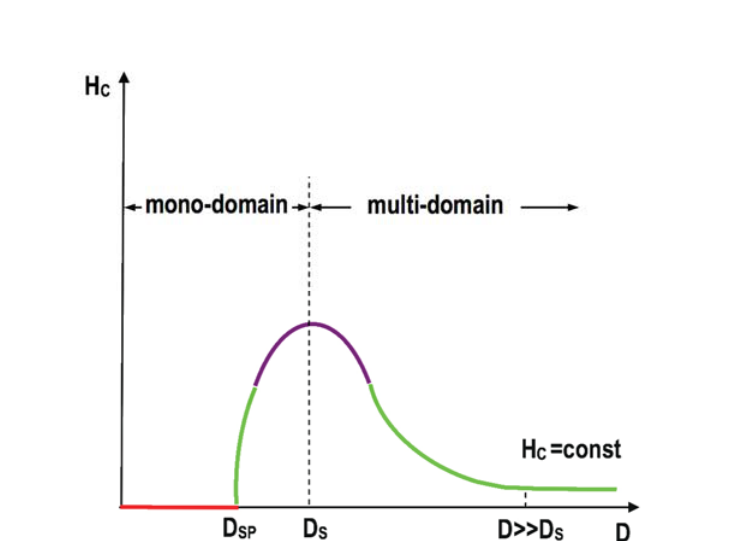
Figure 3 – Coercive field strength as a function of a nanoparticle diameter at a constant temperature. DSP - diameter below which a material shows super-paramagnetic behavior; DS - critical